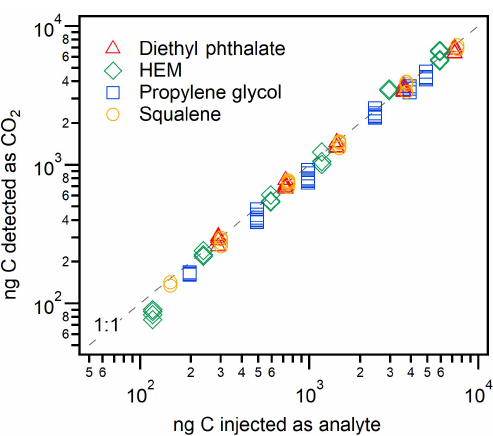
Figure 3. FID combustion efficiency, shown as nanograms of carbon measured by the CO 2 detector versus nanograms C in- jected as one of four analytes: squalene (C 30 H 50 ), diethyl phthalate (C 12 H 14 O 4 ), hydroxyethyl methacrylate (C 6 H 10 O 3 ), and propy- lene glycol (C 3 H 8 O 2 ). Uncertainty is approximately 15% on the y axis and < 10% on the x axis; error bars not included for clarity. Percent conversion for each compound and overall is tabulated in Sect.